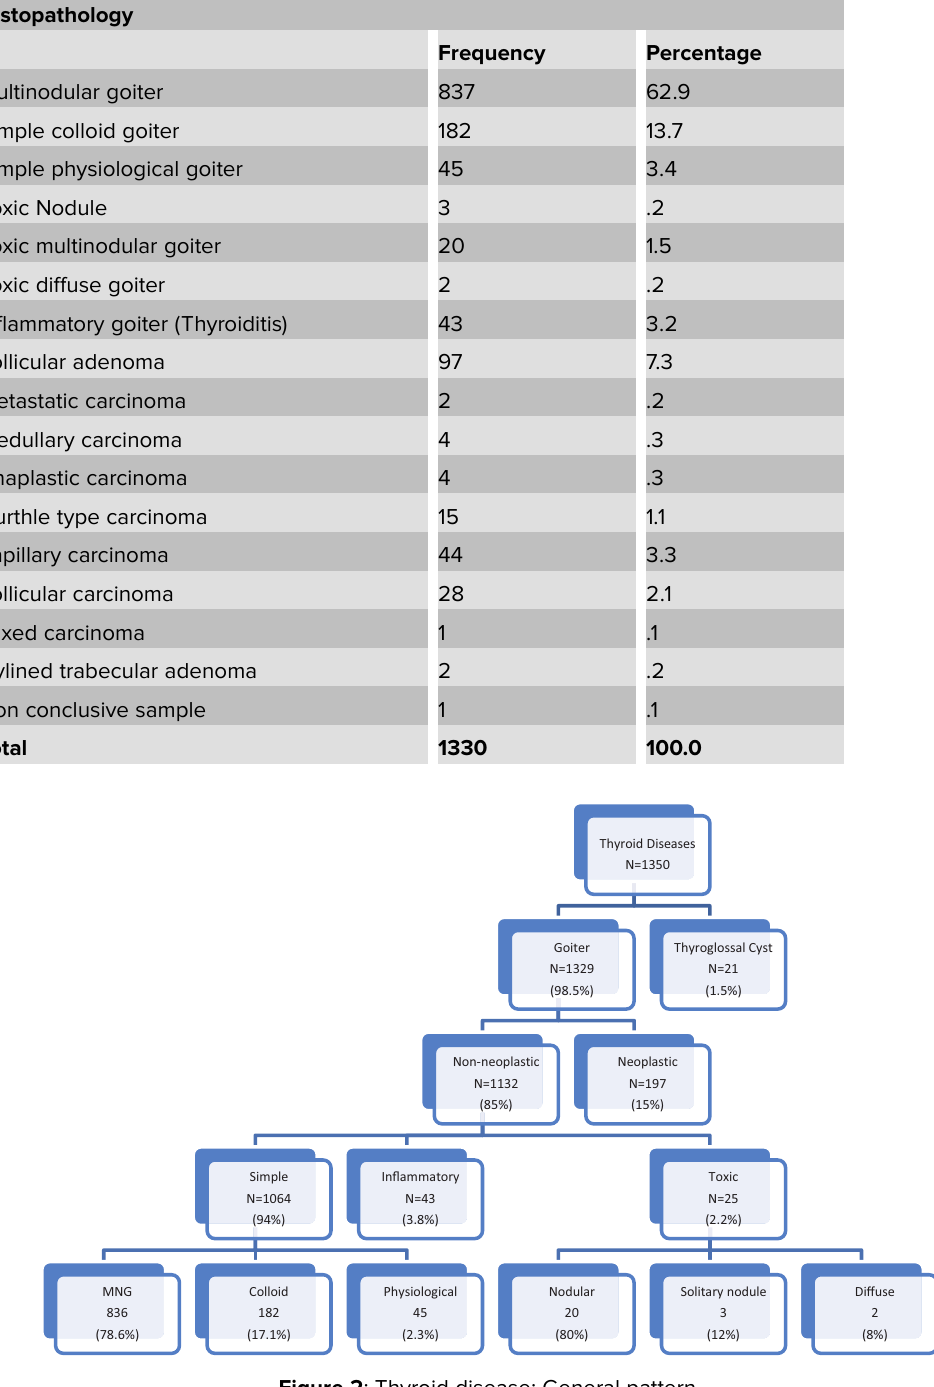
Figure 2 : Thyroid disease: General